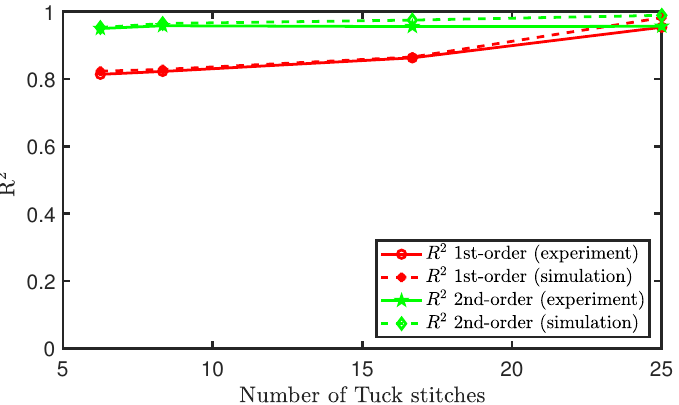
Figure 11. Polynomial fit of the piezoresistive behaviour of sensors with tuck stitches.